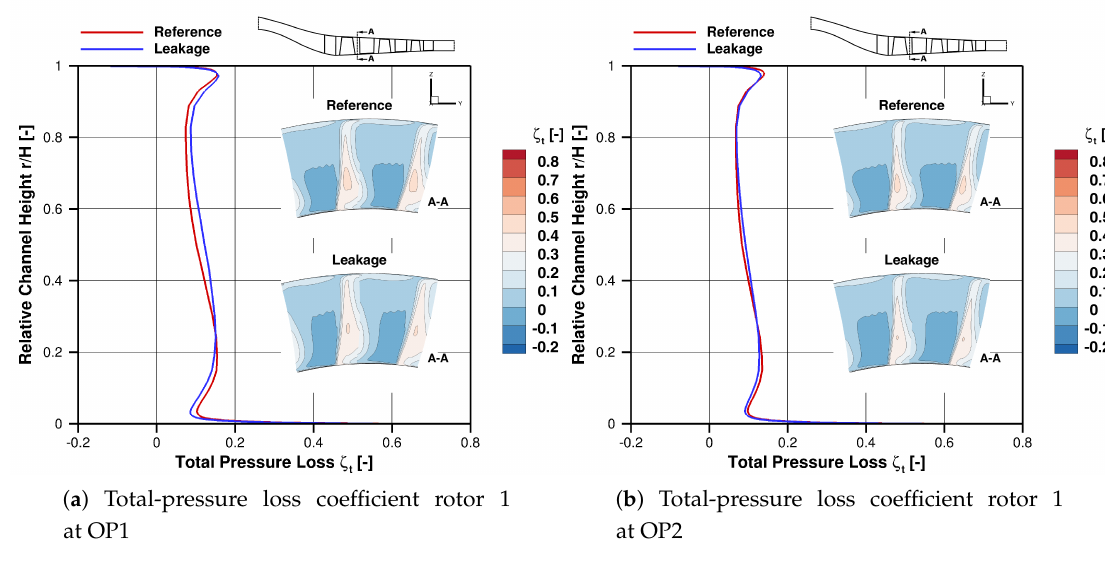
Figure 13. Effect of fan rotor cavity flows on rotor 1 at off-design.